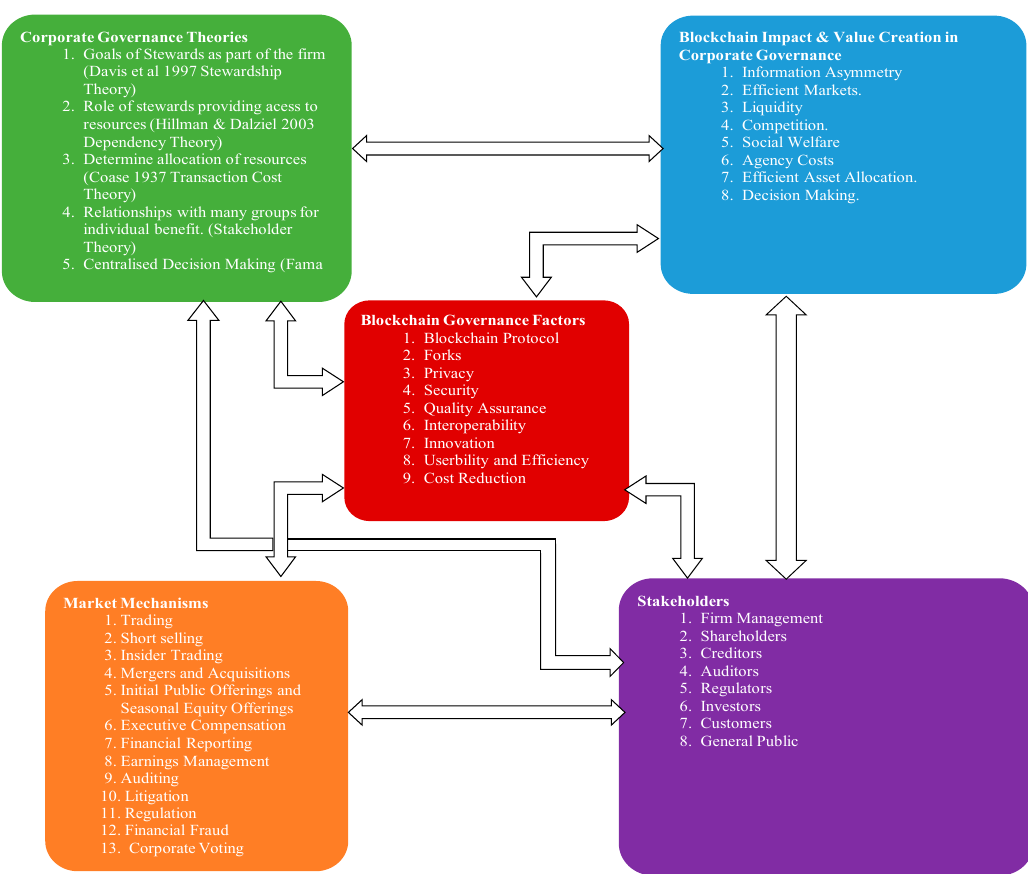
Figure 6. Decentralized autonomous corporate governance.